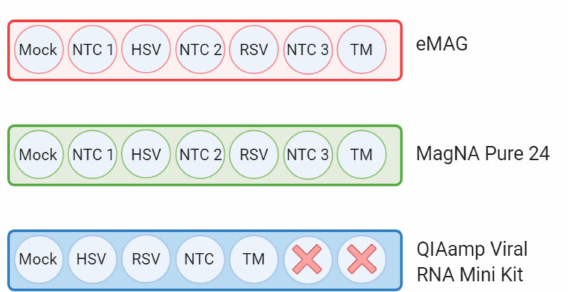
Figure 2. Arrangement of the samples on the extraction platforms. The three di ff erent extraction methods used here were the NucliSENS eMAG platform (bioM é rieux, Marcy l’Etoile, France), MagNA Pure 24 platform (Roche, Basel, Switzerland), and manual QIAamp Viral RNA Mini Kit (Qiagen, Hilden, Germany). Nucleic acids were extracted in triplicate from the same aliquot for each kit according to the manufacturer’s instructions. In order to evaluate cross-contamination during the automated extractions, an NTC was regularly interspersed between samples (7 samples per series). To evaluate the kitome contamination, a transport medium sample was added in addition to NTC. Here, each color represents a di ff erent extraction method. NTC: No Template Control; HSV: Herpes Simplex Virus; RSV: Respiratory Syncytial Virus; TM: Transport